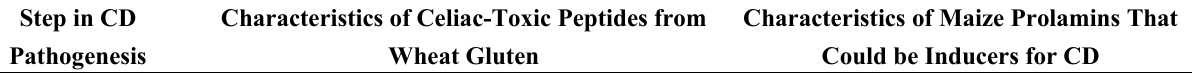
Table 1. Similarities between maize prolamin peptides and wheat celiac-toxic gluten peptides that are involved in the pathogenesis of celiac disease (CD). NO: nitric oxide; NOS: nitric oxide synthase; HLA-DQ2 or DQ8: human leucocyte antigen molecules; IFN- γ : interferon